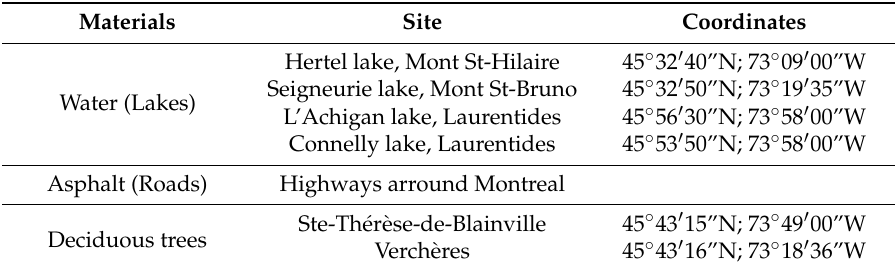
Table 4. Sites used for comparing ground reflectances of selected materials with their values given by the USGS ASTER library. All of these sites are around Quebec, Canada.